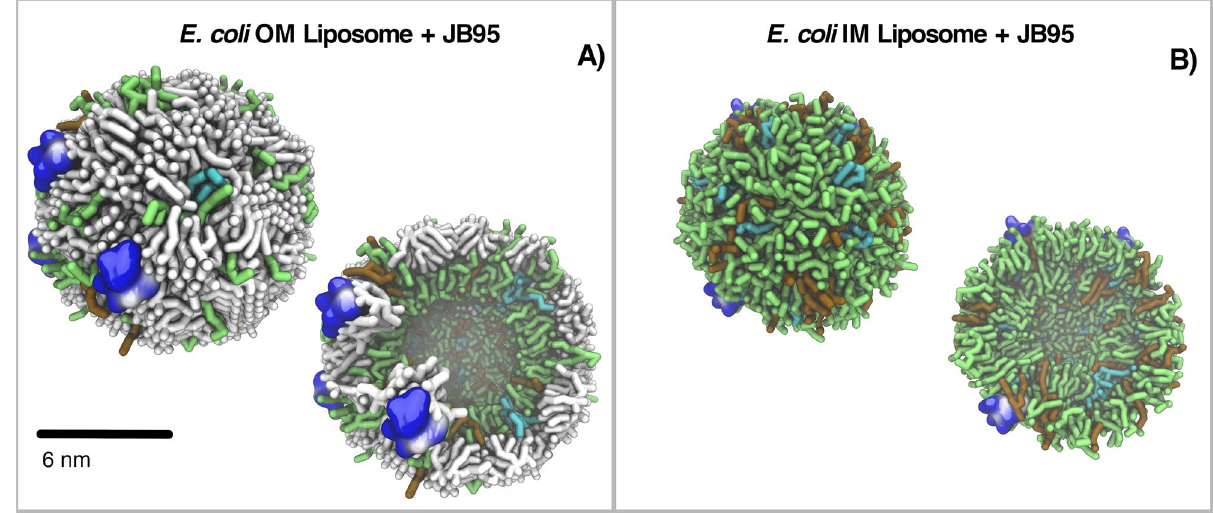
Figure 5. JB95- E. coli liposome interaction. ( A ) JB95-OM liposome and ( B ) JB95-IM liposome for both external and crossed-section views. Lipids are represented in sticks where lipid A is in white, POPE in green, POPG in cyan and CDL in red. JB95 is render by volumetric potential surface where blue represents postive charged aminoacids and white represents hidrophfocbic aminoacids. Water and Ca +2 beads are not included for clarification. 3D structures from last equilibrated